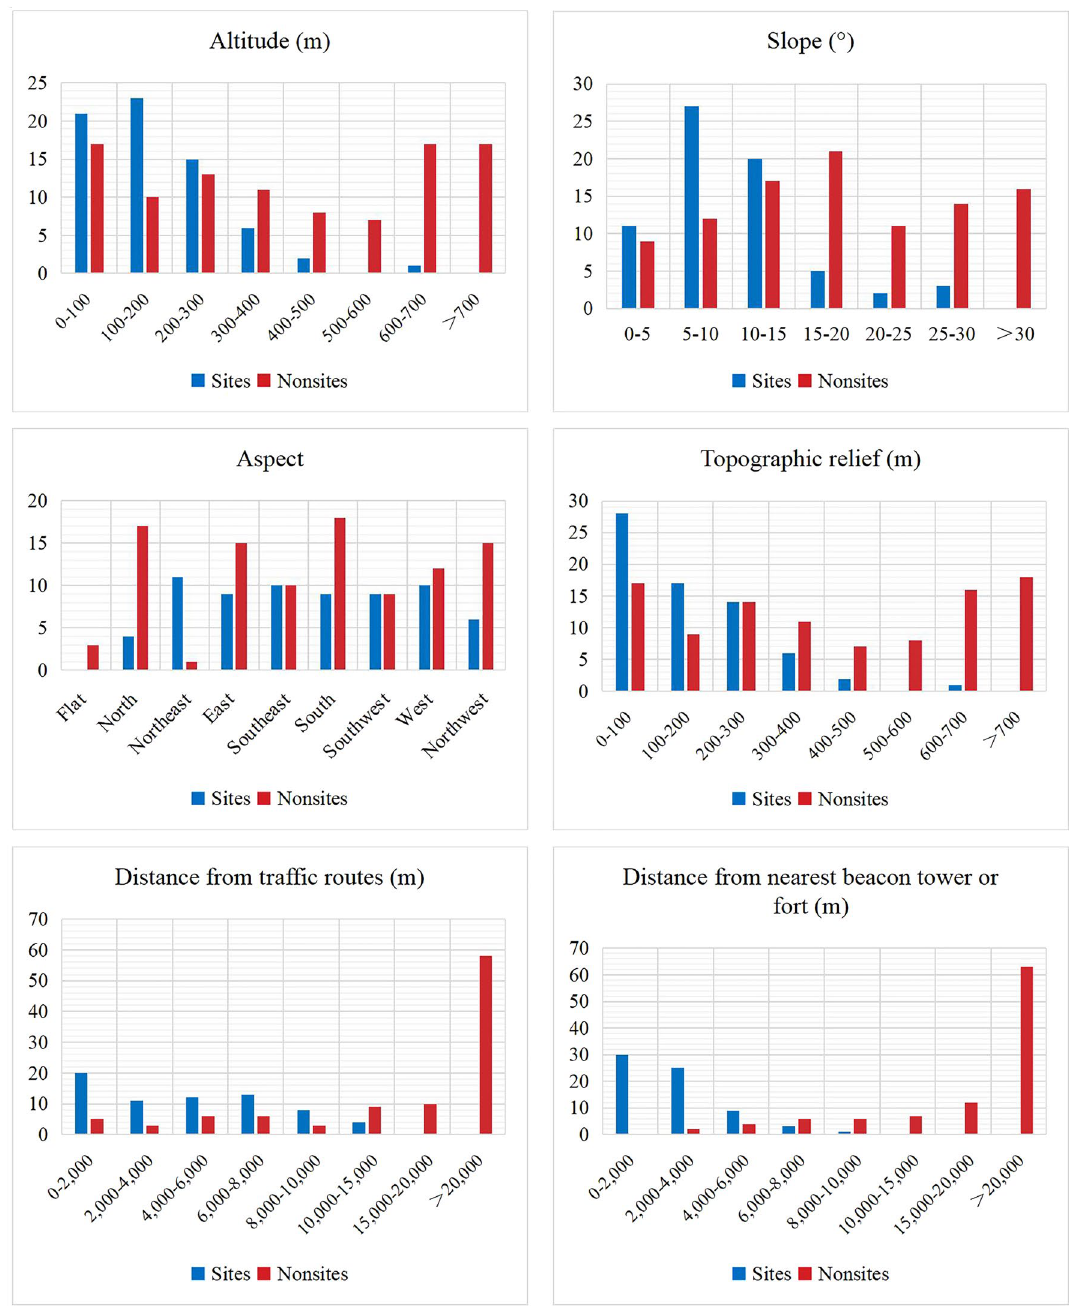
Figure 4. Beacon sites and nonsites distribution